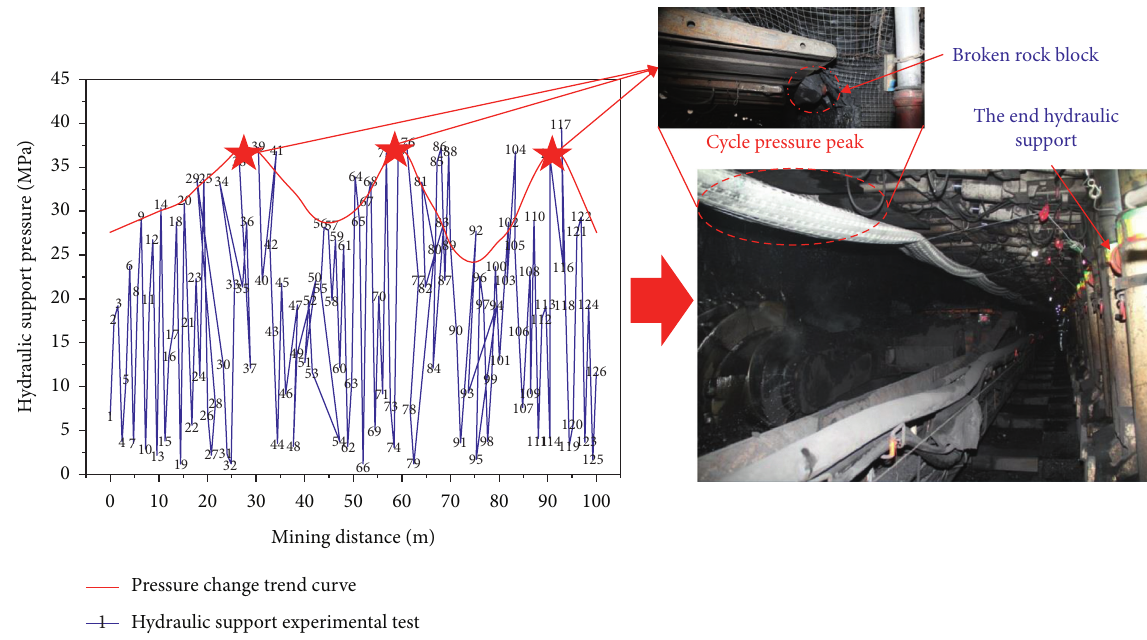
Figure 8: Resistance curve of #95 hydraulic support in the